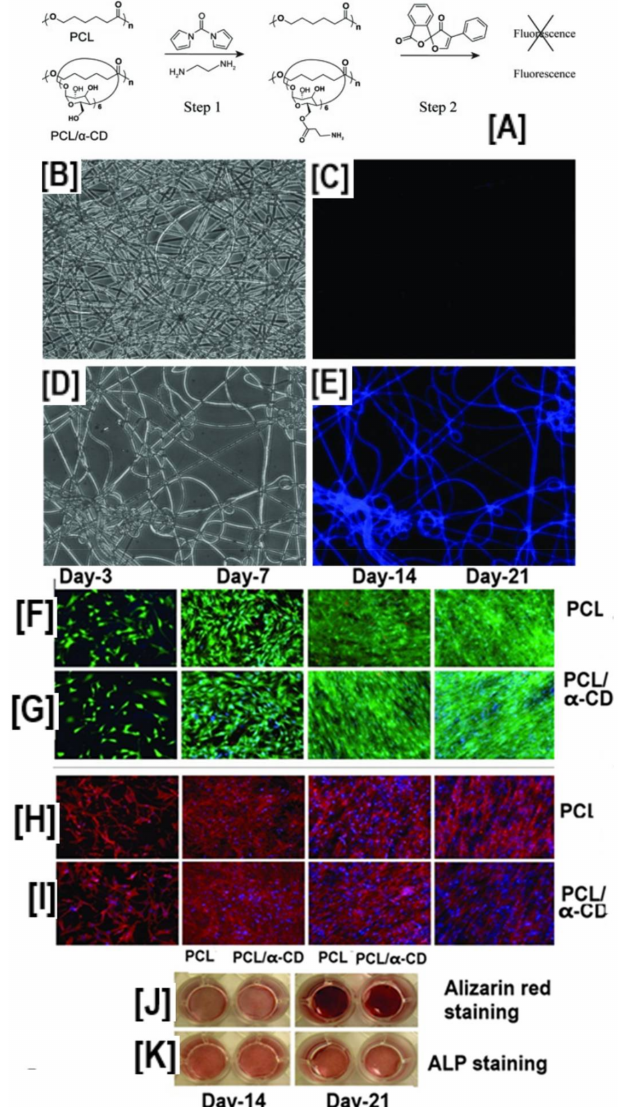
Figure 9. Schematic illustrating the immobilization of fluorescent molecules and the effect of hydroxyl groups of cyclodextrins on the osteogenic differentiation of human adipose-derived stem cells. The Neat PCL does not have surface epitopes facilitating immobilization of bioactive molecules. Conversely, the pseudorotaxanes contain abundant hydroxyl groups, facilitating the immobilization of bioactive molecules, and a representative fluorescent molecule (fluorescamine) ( A ), whose presence was monitored by fluorescent spectroscopy ( B – E ). Although immobilization of active biomolecule was possible only in scaffolds containing CDs, live-dead cell assay and F-actin assay showed no statistical significance in the cell viability at any of the time point studied ( F – I ) In addition to facilitating the immobilization of bioactive molecules, PCL/ α -CD nanofibers without immobilization of biomolecules also facilitated the osteogenic differentiation of human adipose derived stem cells (h-ADSCs), although the osteogenic marker levels showing similarities in the expression levels between the study groups were the same ( J,K ). Images adapted and reproduced with permission from [103]. Copyright Springer